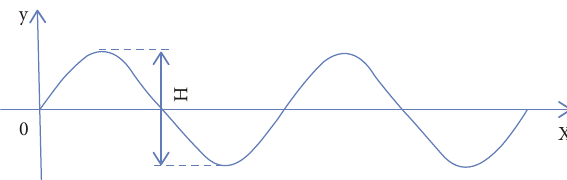
Figure 5: Distribution characteristics of surface